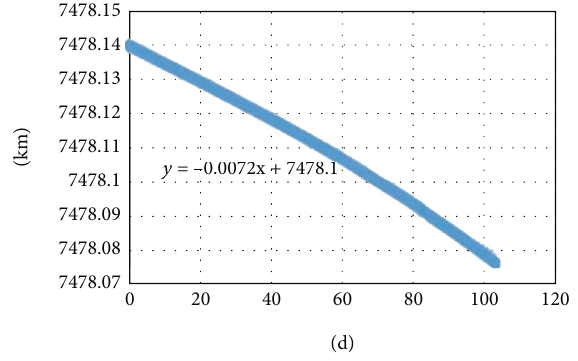
Figure 5: Attenuation of half major axis of satellite in high solar activity year. Table 1: Satellite initial orbit element intake error and acquisition error